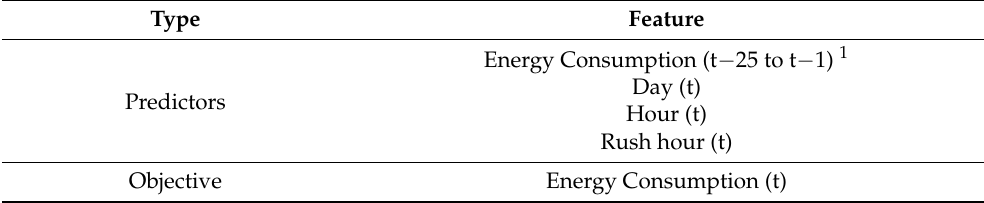
Table 2. Database Table 2. Database variables.